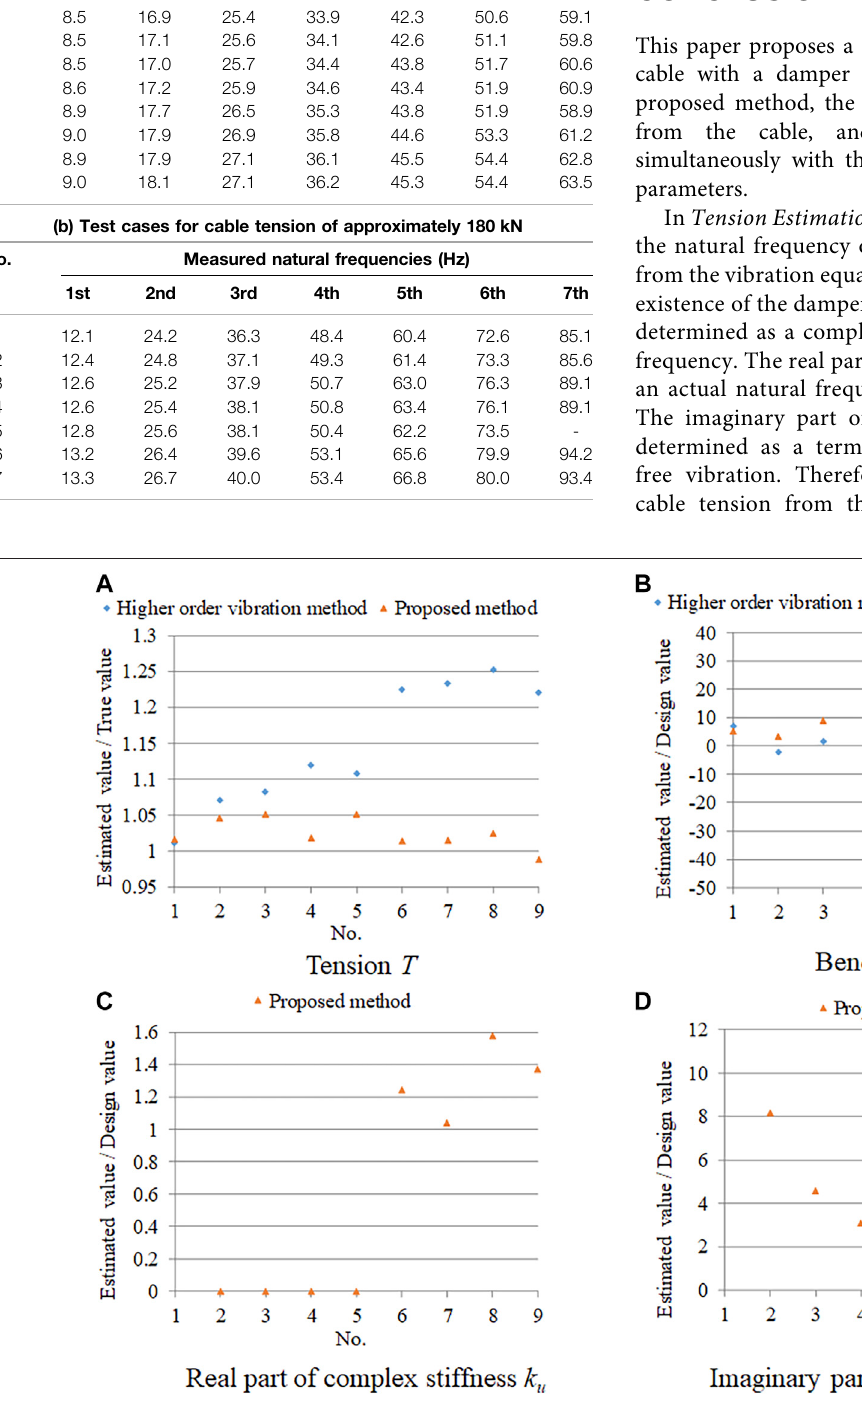
FIGURE10| EstimationaccuracyforNos.1 – 9(80 kN): (A) tension; (B) bendingstiffness; (C) realpartofcomplexstiffness; (D) imaginarypartofcomplexstiffness.